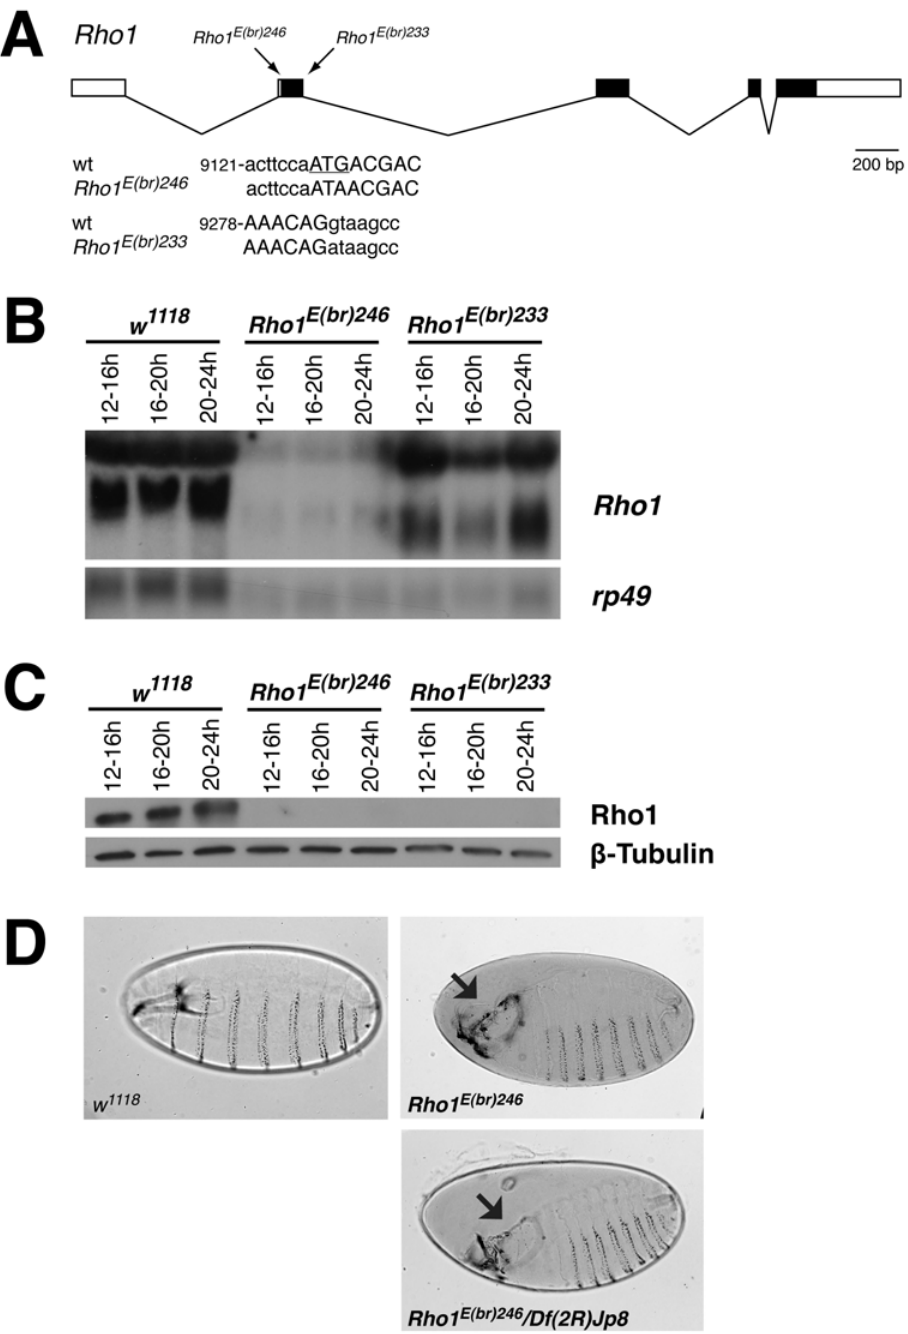
Figure 2. Molecular and genetic characterization of Rho1 E(br)246 and Rho1 E(br)233 . (A) Schematic diagram of the Rho1 transcript. Exons are indicated by boxes with coding regions filled in black. The locations of the Rho1 E(br)246 and Rho1 E(br)233 mutations are indicated above the diagram and the molecular lesions are shown in the sequences below. 5 9 untranslated sequence and intronic sequences are written in lowercase letters while coding sequence is written in capital letters. The ATG start codon is underlined. The number refers to the sequence from genomic clone AF177871. (B) Northern blot analysis of total RNA isolated from w 1118 , Rho1 E(br)246 , and Rho1 E(br)233 mutant embryos at 12–16 hrs, 16–20 hrs, and 20–24 hrs after egg laying. Hybridization to rp49 was used as a control for loading and transfer, and indicates that the Rho1 samples are underloaded relative to w 1118 . Hybridization of the blot with Rho1 indicates that Rho1 E(br)246 produces substantially less Rho1 transcripts, whereas Rho1 E(br)233 produces transcripts at , wild type levels but with altered size. The two prominent bands in the w 1118 samples are the 2.1 kb and 1.3 kb transcripts described by [12]. (C) Western blot analysis of total protein lysate isolated from w 1118 , Rho1 E(br)246 , and Rho1 E(br)233 mutant embryos at 12–16 hrs, 16–20 hrs, and 20–24 hrs after egg laying. No Rho protein is observed in Rho1 E(br)246 or Rho1 E(br)233 mutant embryos. b -Tubulin was used as a control for loading and transfer. (D) Brightfield photomicrographs of cuticle preparations of w 1118 , Rho1 E(br)246 and Rho1 E(br)246 /Df(2R)Jp8 mutant embryos. All animals are shown with anterior to the left and the dorsal surface up. All Rho1 E(br)246 and Rho1 E(br)246 /Df(2R)Jp8 mutant animals die as embryos, with nearly completely penetrant defects in head involution (arrows point to dorsal anterior holes in the cuticle).